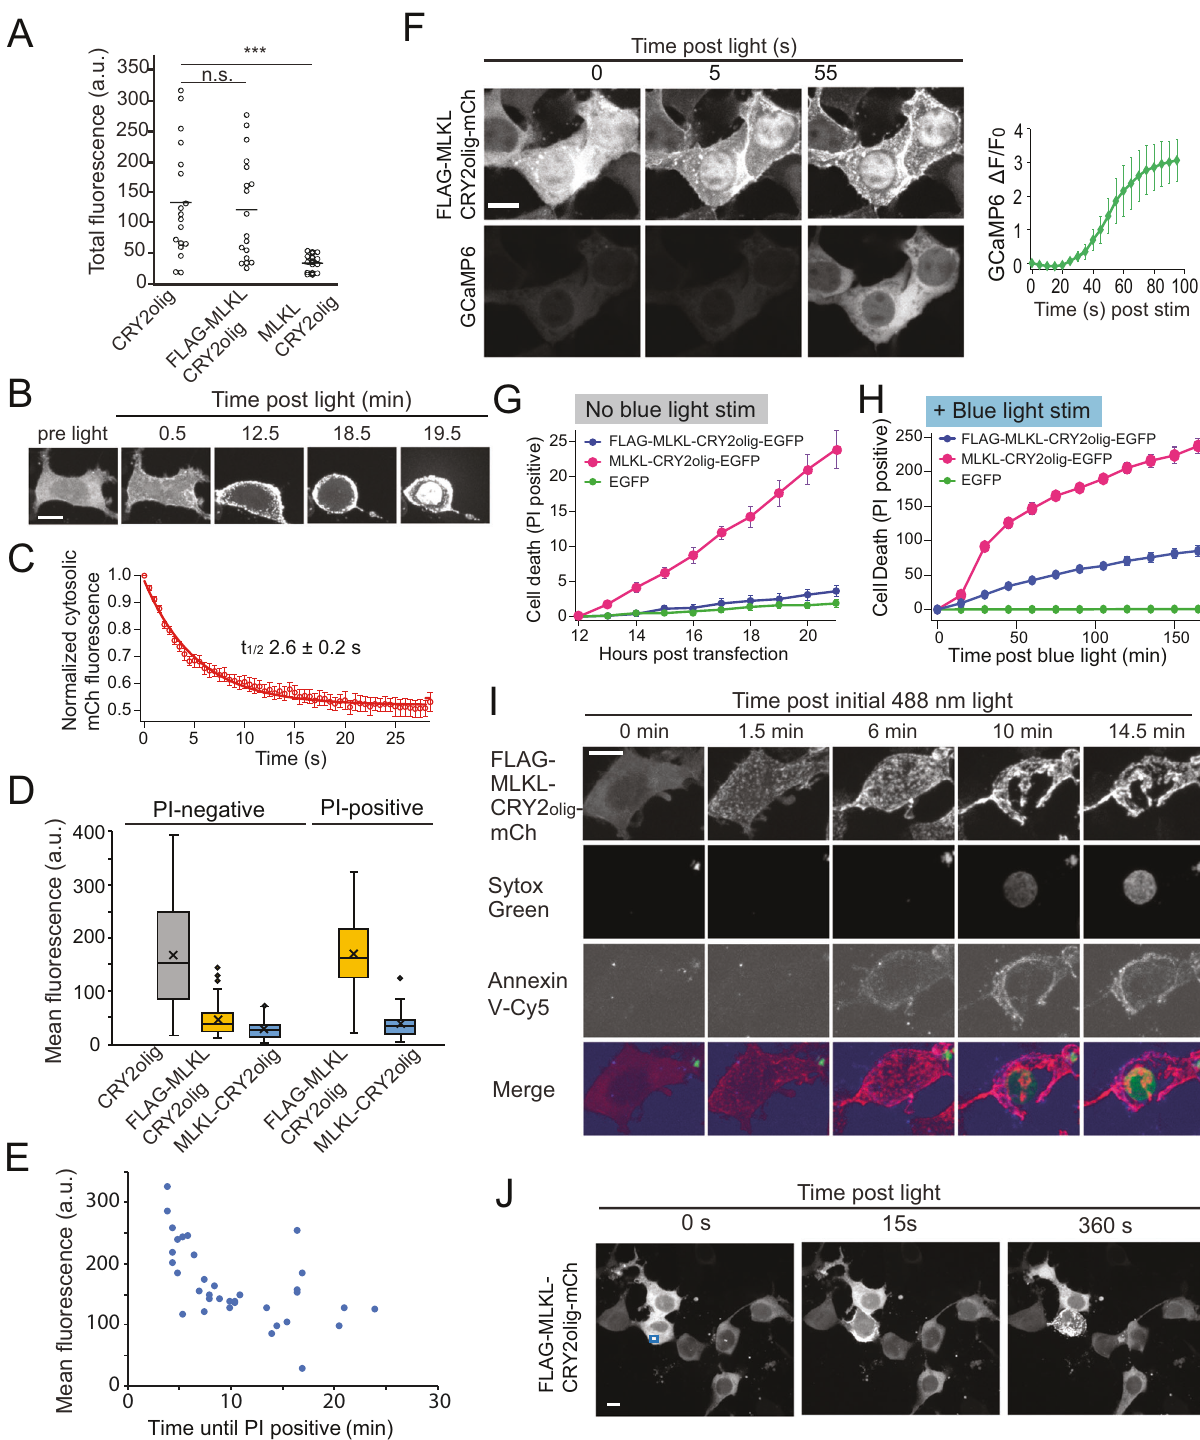
neighbor cells [29, 30]. As DAMPs can induce spikes in intracellular Ca 2 + in neighboring cells [31], we wanted to con fi rm that the Ca 2 + changes we observed in Fig. 2F were due to cell-autonomous processes, rather than DAMPs. To observe DAMP signaling, we co- cultured cells expressing FLAG-MLKL (dying cells) with cells that were separately transfected with GCaMP6 (bystander cells). Upon light activation, MLKL-expressing cells showed rapid PM transloca- tion of MLKL, followed minutes later by the appearance of a